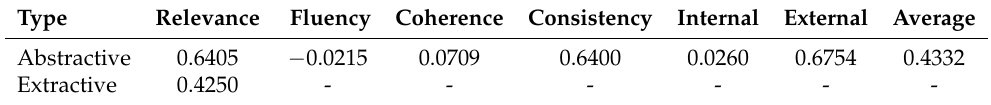
Table 9. Krippendorff’s alpha agreement metric on each human evaluation metric for each summary type. The internal metric is the average of fluency and coherence metrics. The external metric is the average of relevance and consistency metrics. In the abstractive summaries category, we included both reference and generated abstractive summaries as human evaluators were evaluated both in the same way and in a randomized order without knowing if any of the summaries were written by legal experts.